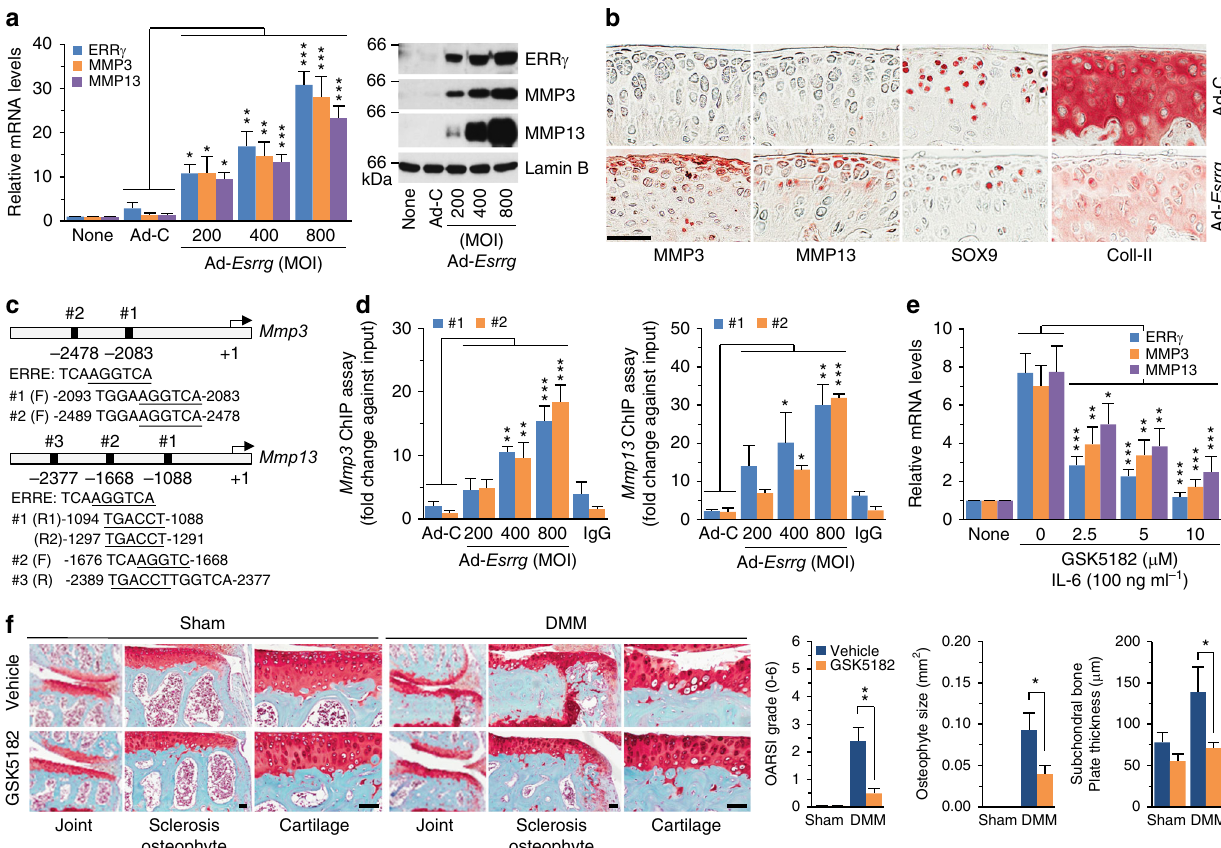
Fig. 7 ERR γ directly upregulates MMP3 and MMP13 in chondrocytes. a The mRNA (left) and protein (right) levels of ERR γ , MMP3, and MMP13 in primary cultured chondrocytes infected with Ad-C (800 MOI) or the indicated MOI of Ad- Esrrg for 36 h ( n = 12). b Representative images showing immunostaining for MMP3, MMP13, SOX9, and type II collagen (Coll-II) in cartilage sections of mice obtained after 3 weekly IA injections with Ad-C or Ad- Esrrg ( n = 12 mice per group). c The ERRE sequences in the promoter regions of Mmp3 and Mmp13 are indicated. d Quantitative ChIP assays were performed, and the data are presented as fold-changes relative to each input ( n ≥ 4). e qRT-PCR ( n = 11) analyses of MMP3 and MMP13 expression in chondrocytes treated with IL-6 (100 ng ml – 1 ) in the presence of the indicated concentrations of GSK5182, an inverse agonist of ERR γ . f Sham-operated or DMM-operated mice were IP-injected with GSK5182 and killed 8 weeks after the operation. Representative images of safranin-O staining and scoring of OARSI grade, osteophyte size, and subchondral bone plate thickness ( n = 10 mice per group). Values are presented as means ± s.e.m. (* P < 0.05, ** P < 0.005, and *** P < 0.0005). One-way ANOVA ( a , d , e ), two-tailed t test ( f ), and Mann – Whitney U test ( f ). Scale bar: 50 μ